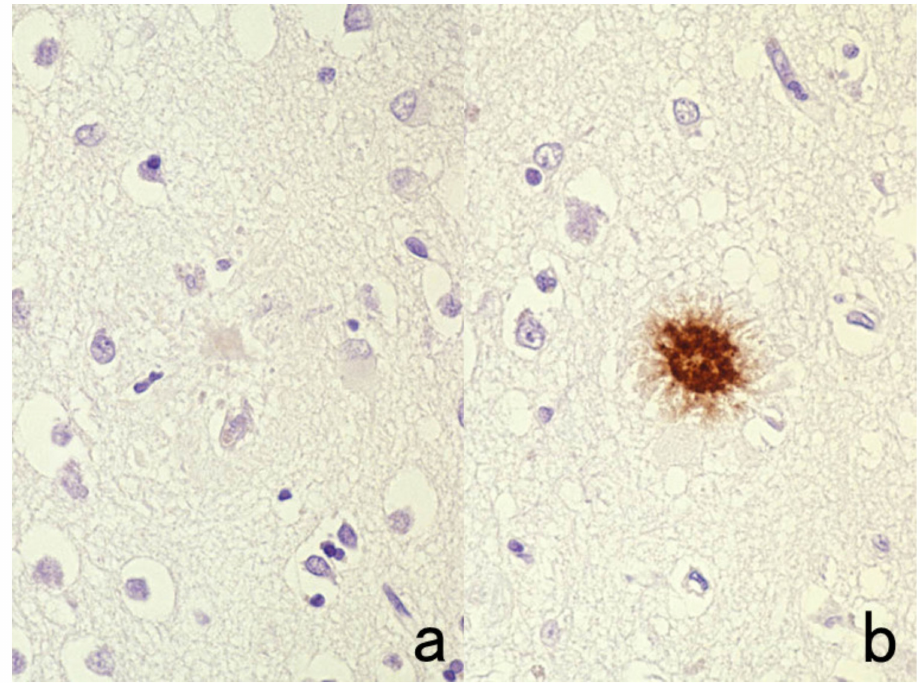
Figure 43. Retrieval of β -amyloid immunoreactivity in the brain by formic acid pretreatment. ( a ): Without treatment and ( b ): with 100% formic acid treatment for 5 min. Brief soaking in formic acid retrieves β -amyloid immunoreactivity of senile plaques in Alzheimer’s disease. A polyclonal antibody available from Agilent Co., Santa Clara, CA, USA, was